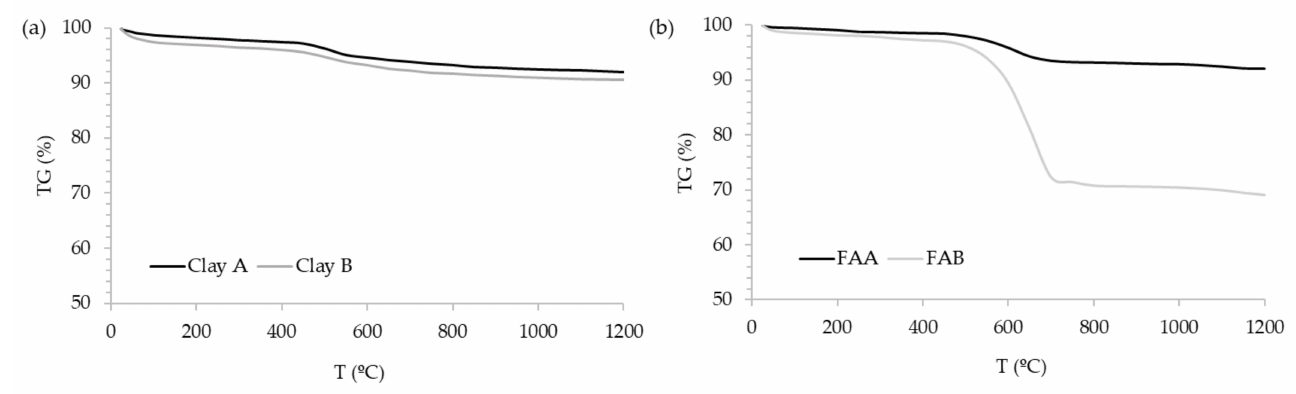
Figure 4. Thermogravimetric behaviour of ( a ) clay A and clay B; ( b ) FAA and